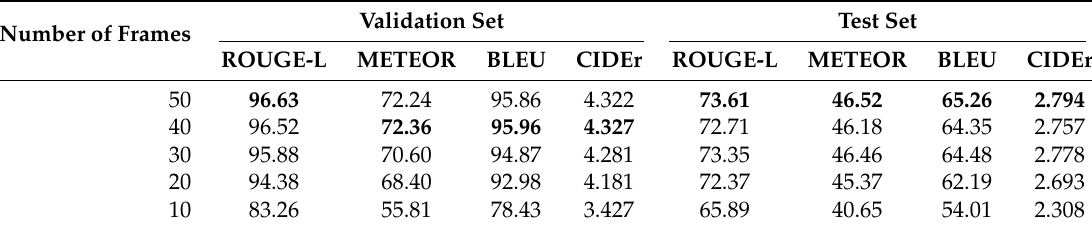
Table 8. Effects of the number of sampled frames on sign language translation performance. Number of Frames